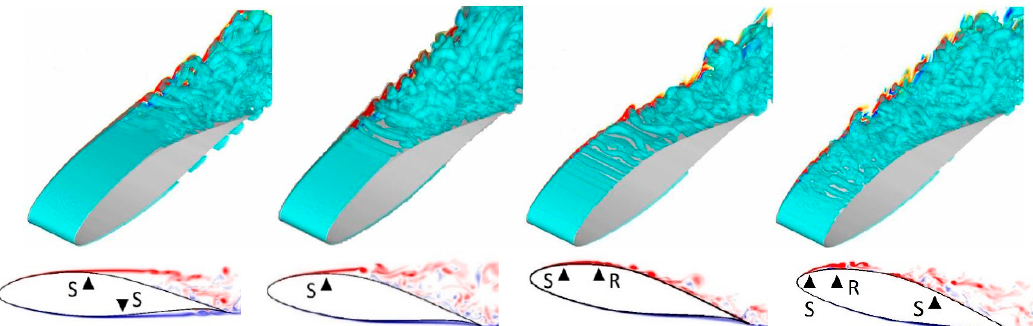
Figure 19. Instantaneous flow visualizations of Q = 100 and spanwise vorticity ( − 100 < ω z < 100) with mean separation (S) and reattachment (R) for Re = 64,200 and α = 4.19 degrees, 8.64 degrees, 11.24 degrees, and 13.84 degrees ( left to right ). (Reprinted from [32]).